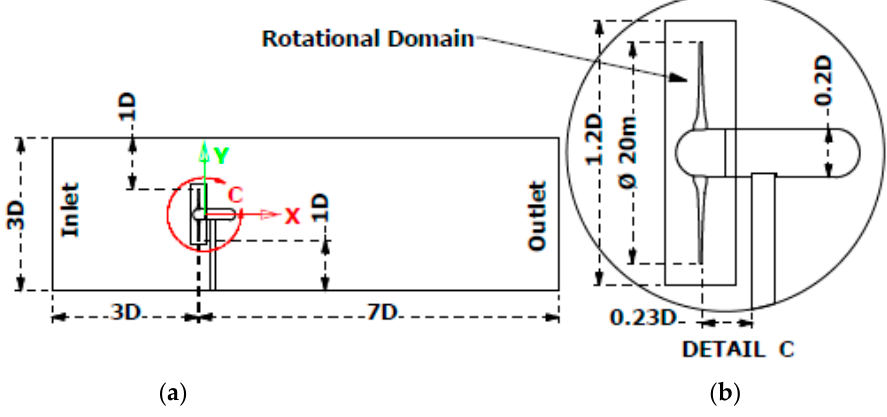
Figure 2. Dimensions of the ( a ) Fluid domain; ( b ) Turbine.